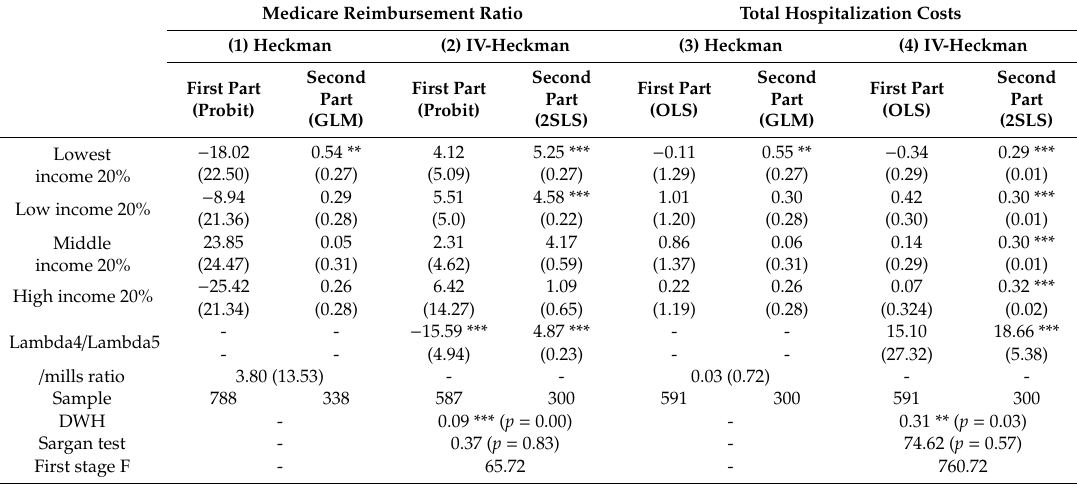
Table 5. Medical insurance compensation level and total hospitalization expenses with social medical assistance